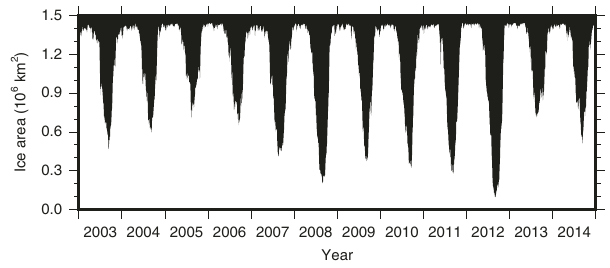
Fig. 4 Area of sea ice. Time series of sea ice area (10 6 km 2 ) in the Beaufort Gyre region corresponding to the blue box in Fig. BG, particularly from 2008 onwards. Overall, the picture is one of a more energetic BG system since 2007, with increased energy sources and sinks and increased eddy diffusivity balancing and dissipating APE, and FWC stabilization by eddies required to balance net Ekman downwelling (Fig. 5).